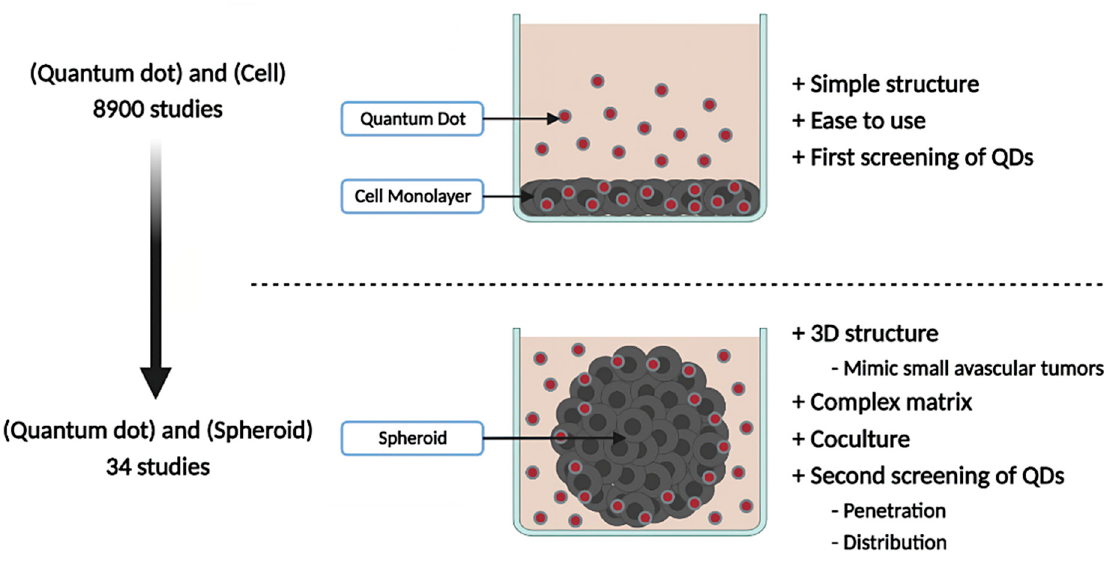
Figure 2. Advantages of QDs studies in 3D over 2D models. The majority of QDs studies are conducted on 2D cell models, having the advantage of being simple, easy to use, and necessary for the first screening of QDs candidates. 3D models such as spheroids allow to evaluate QDs behavior in small avascular tumors.